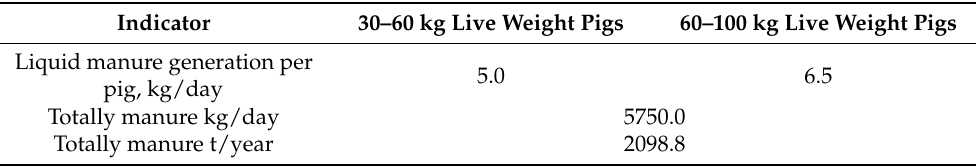
Table 1. On-farm liquid manure